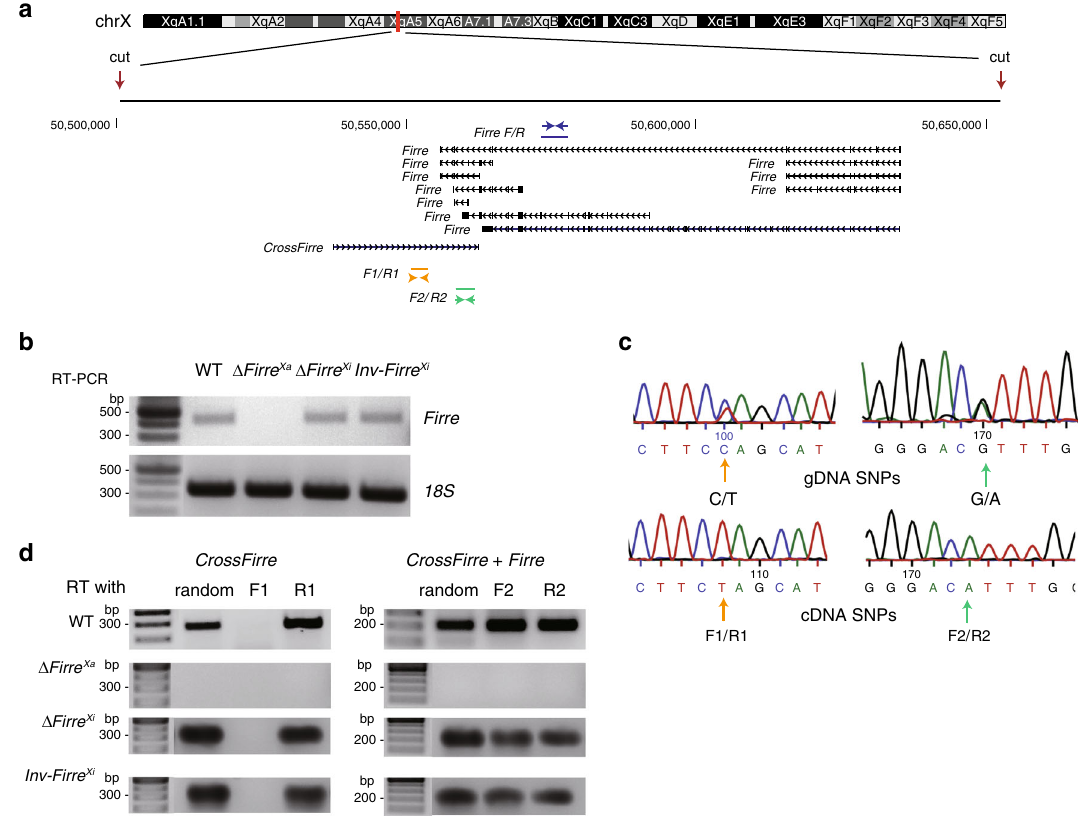
Fig. 1 Firre and CrossFirre are expressed from the Xa. a Genomic location of Firre and CrossFirre ( Gm35612 ) on the mouse X chromosome (UCSC mm10 build 38 browser tracks). Note that Firre has multiple alternative transcripts. The locations of the CRISPR guide RNAs used to edit the locus (cut), and of the RT-PCR primer pairs to speci fi cally detect Firre expression (F/R), strand-speci fi c expression of CrossFirre (F1/R1), or strand-speci fi c expression in a region of overlap between Firre and CrossFirre (F2/R2) are indicated. b RT-PCR analysis using the F/R primer pair detects Firre expression in WT, Δ Firre Xi , and Inv Firre Xi , but not in Δ Firre Xa . Firre expression was measured in n = 3 biologically independent samples per cell type. c Sanger sequencing analyses of a CrossFirre region (F1/R1) and of a region of overlap between Firre and CrossFirre (F2/R2) con fi rm heterozygosity of SNPs (BL6 on the Xi and spretus on the Xa) in each region assayed. Genomic DNA (gDNA) shows heterozygosity at the SNPs, while cDNA only shows expression from the spretus SNP (Xa). d Strand-speci fi c analysis of CrossFirre and Firre was done using reverse transcription using either random primers, or F1, R1, F2, R2 primers, followed by PCR using F1/R1 or F2/R2 primer pairs. Firre and CrossFirre expression was measured in n = 3 biologically independent samples per cell type. Source data are provided as a Source Data fi